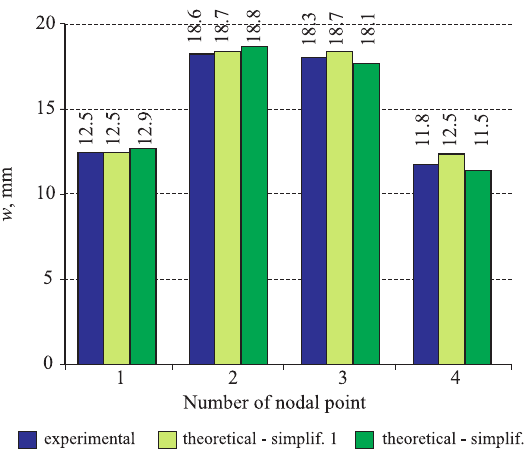
Fig. 11. Comparison of max vertical displacements of nodal points between experimental results and numerical calculations (model scale